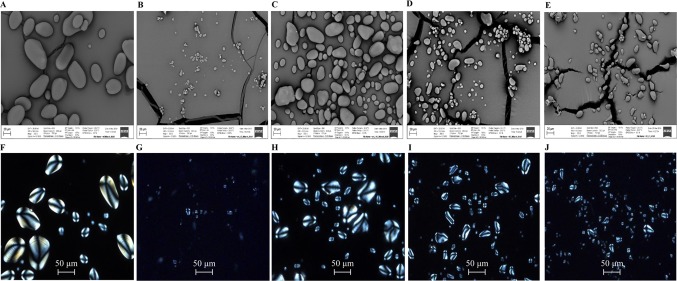
Microscopic observation of starch granules in mature potato tubers. (A) scanning electron microscopy (SEM) image of WT; (B) SEM image of WT-L5; (C) SEM image of WT-L10; (D) SEM image of HO69; (E) SEM image of 69-L3; (F) Polarized light image of WT; (G) Polarized light image of WT-L5; (H) Polarized light image of WT-L10; (I) Polarized light image of HO69; (J) Polarized light image of 69-L3. The starch granules were observed under a view of 300× magnification in the SEM, with scale bars located in the lower left corner for each photograph. Sizes of the scale bars are all normalized to 20 µm. For the images taken by light microscopy, the scale bars are located in the lower middle position of each photograph. Size of the scale bars are normalized to 50 µm.